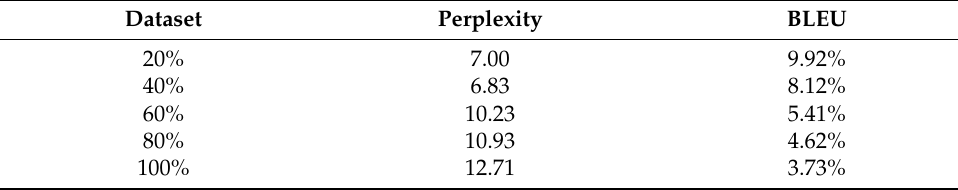
Table 7. Performances using partial